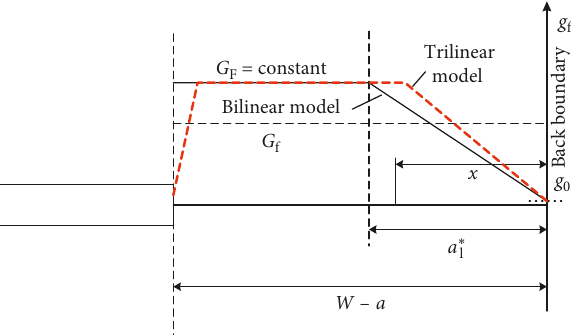
Figure 5: Distribution models describing local fracture energy g